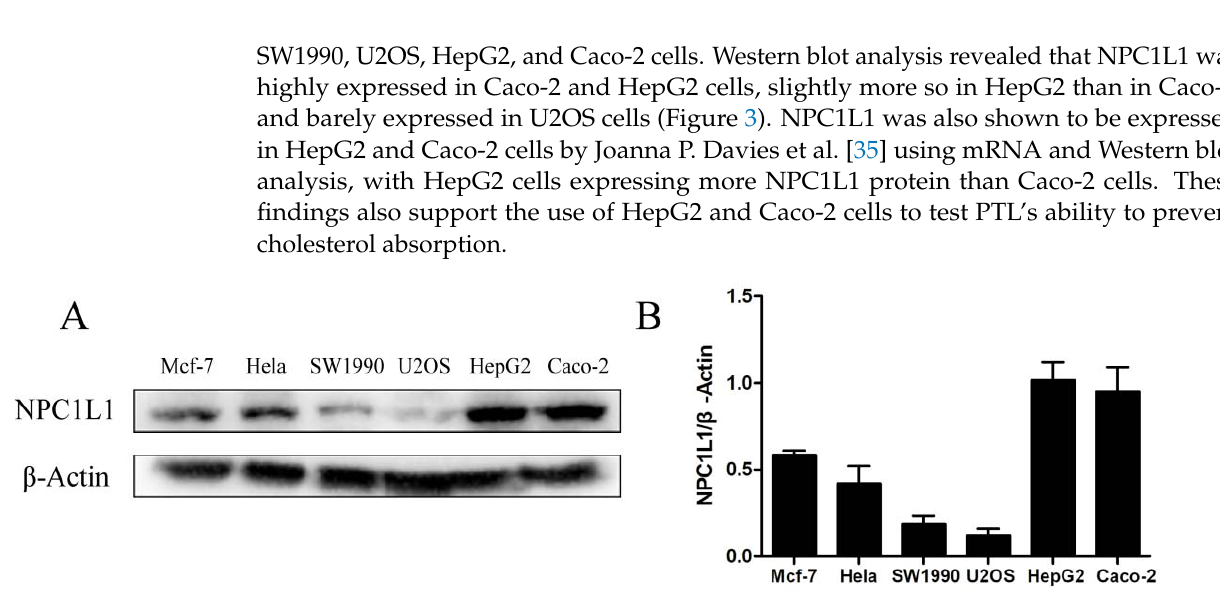
Figure 3. Expression of NPC1L1 in Mcf-7, Hela, SW1990, U2OS, HepG2, and Caco-2 cells. ( A ) Western blot analysis of cells after standard culture in medium A with 10% FBS. ( B ) A statistical representation of Western blot results.